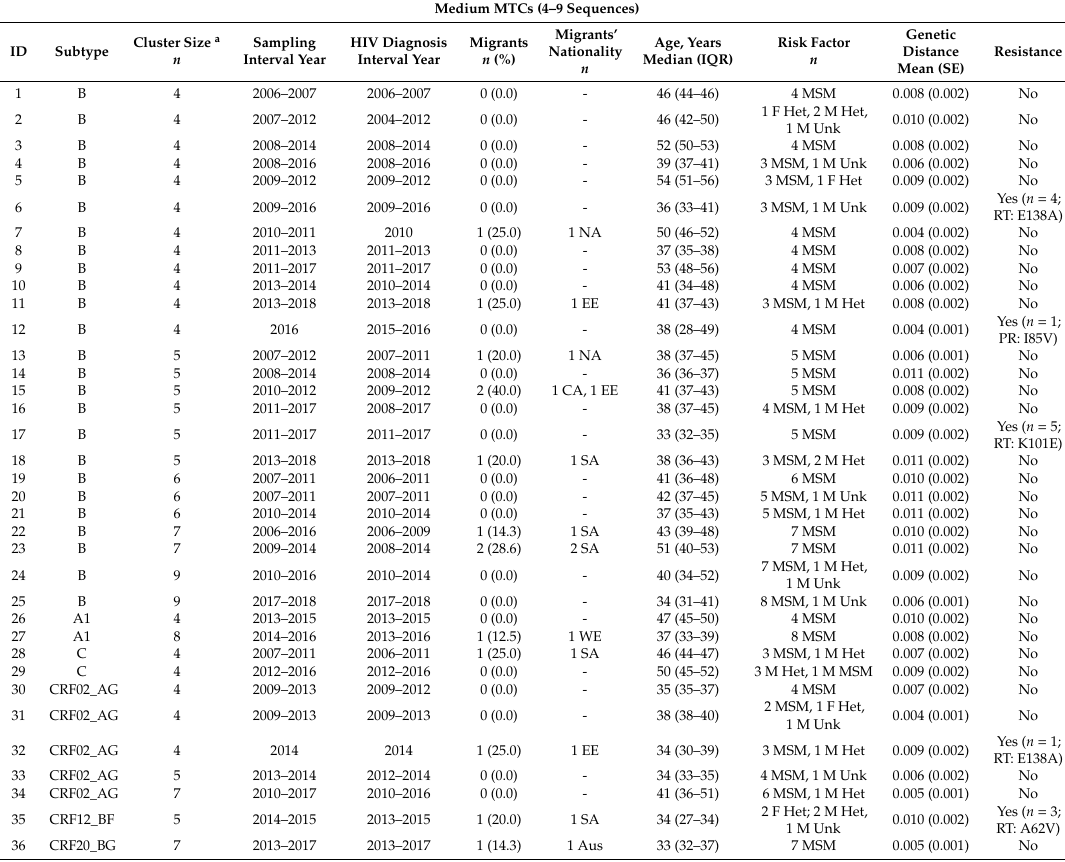
Table 3. Clusters